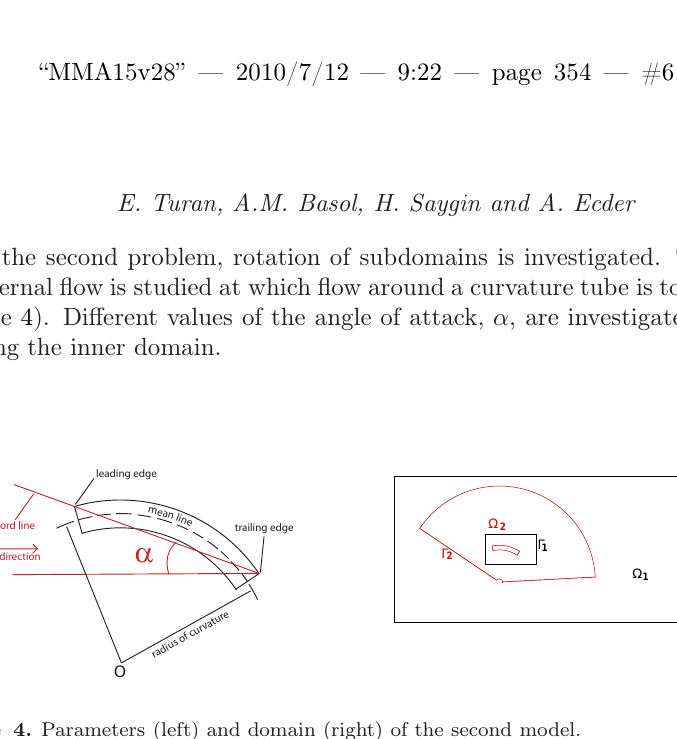
Figure 4. Parameters (left) and domain (right) of the second model.